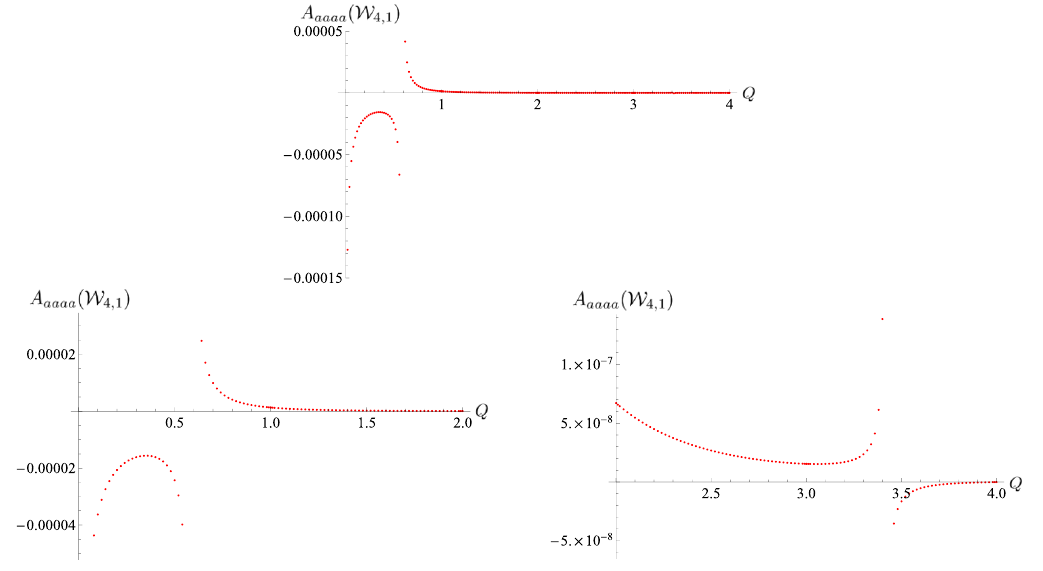
Figure 9 . The bootstrap result of the amplitude A aaaa ( W 4 , 1 ) and its detailed pole structure in the regions 0 < Q < 2 and 2 < Q < 4